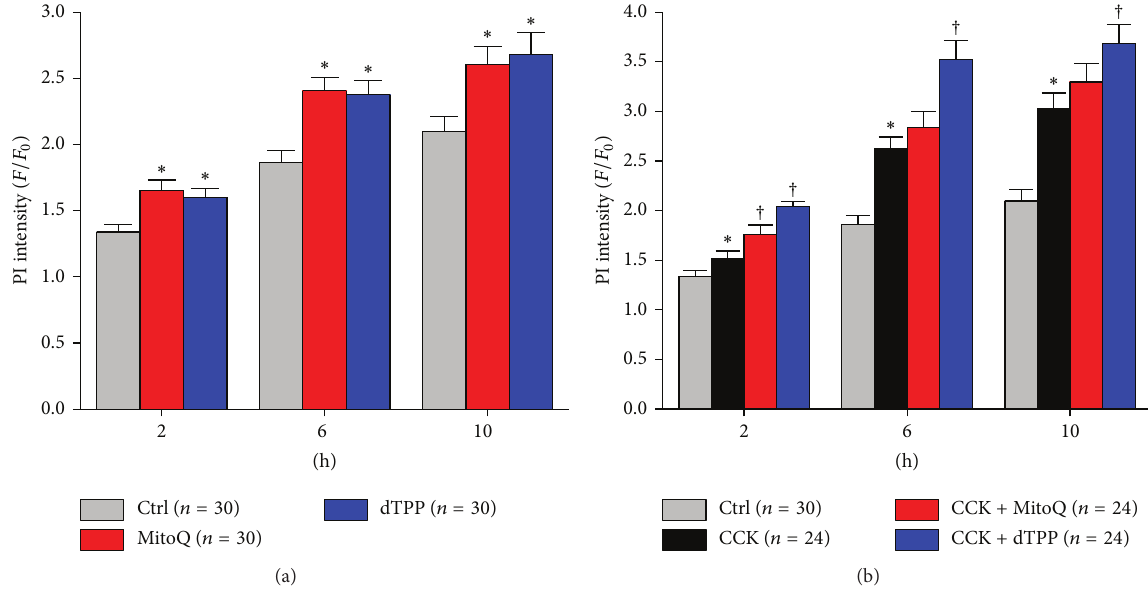
Figure 3: Effects of MitoQ on cell death in isolated pancreatic acinar cells. (a) Both 1 𝜇 M MitoQ and dTPP caused significant increases in necrosis, demonstrated by an increase in PI fluorescence compared with cells in the control group. (b) Both 1 𝜇 M MitoQ and dTPP worsened CCK-induced cell death. ∗ 𝑃 < 0.05 compared with control group, † compared with CCK group. ( 𝑛 ≥ 3 mice per